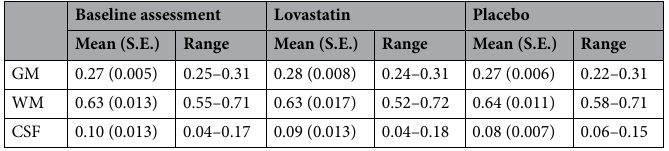
Table 1. MRS voxel tissue proportions. S.E. standard error, GM gray matter, WM white matter, CSF cerebrospinal fluid.